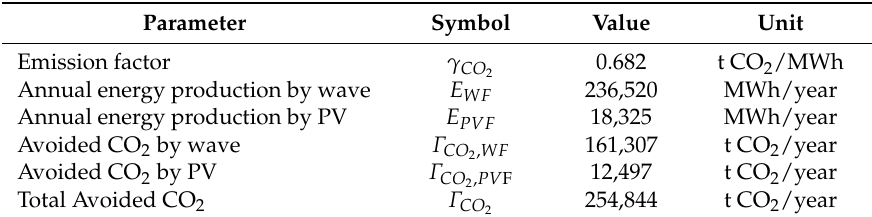
Table 4. Avoided CO 2 emissions by wave and solar